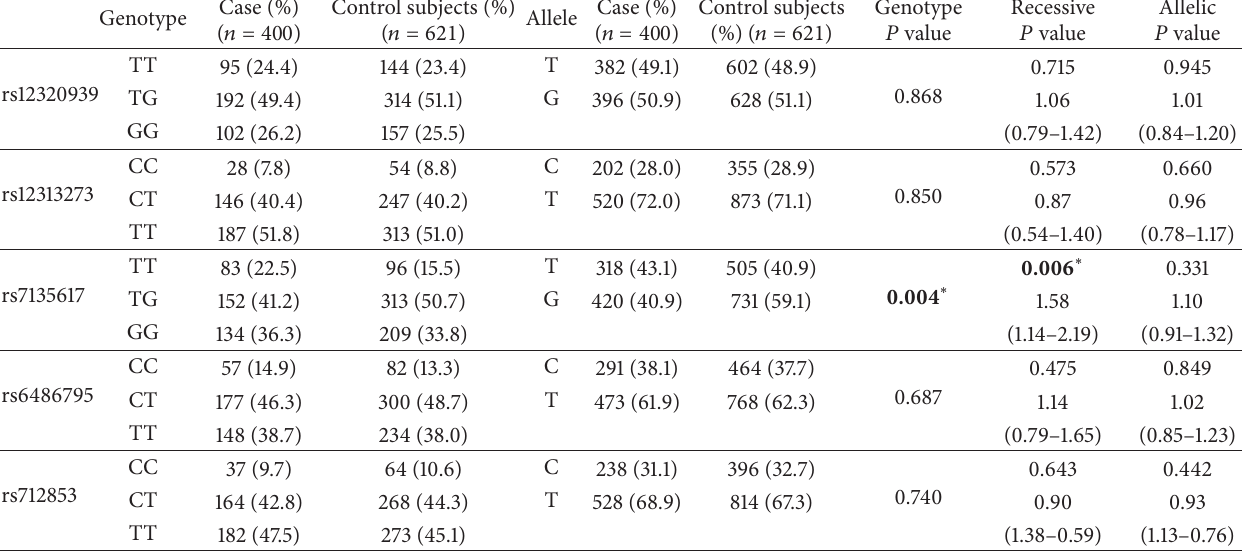
Table 2: Genotyping and allele frequency of ORAI1 gene in rheumatoid arthritis patients and normal controls. Genotype